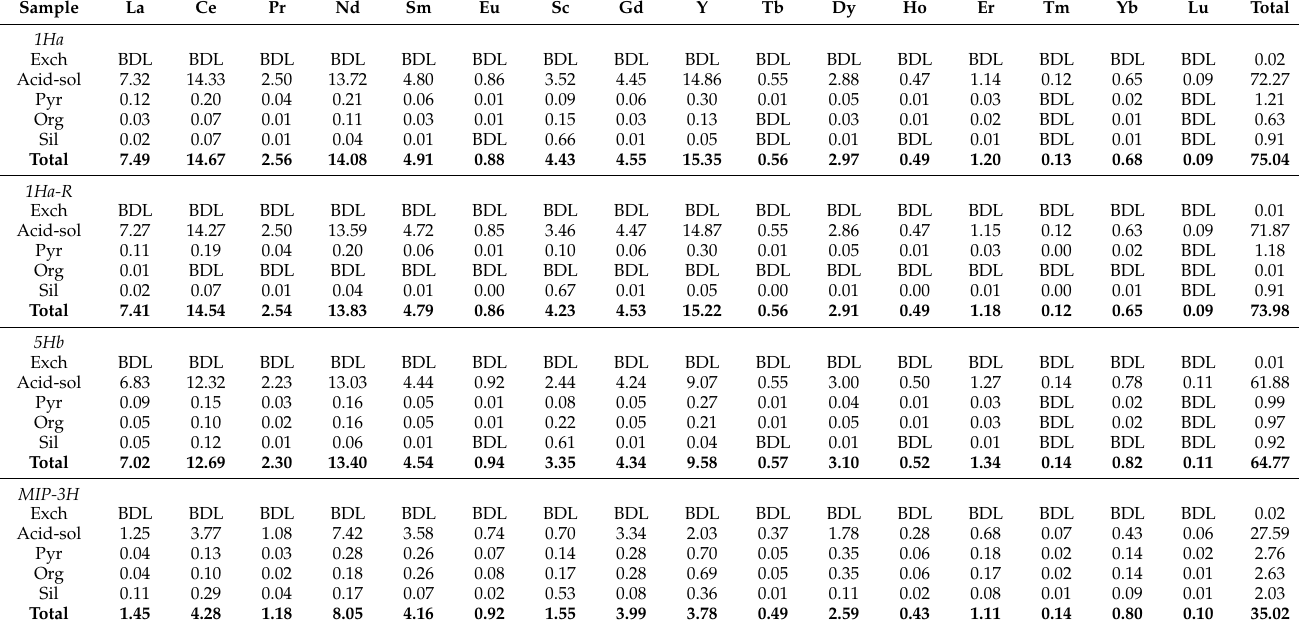
Table 3. Concentrations of each REY in each leachate in ppm.